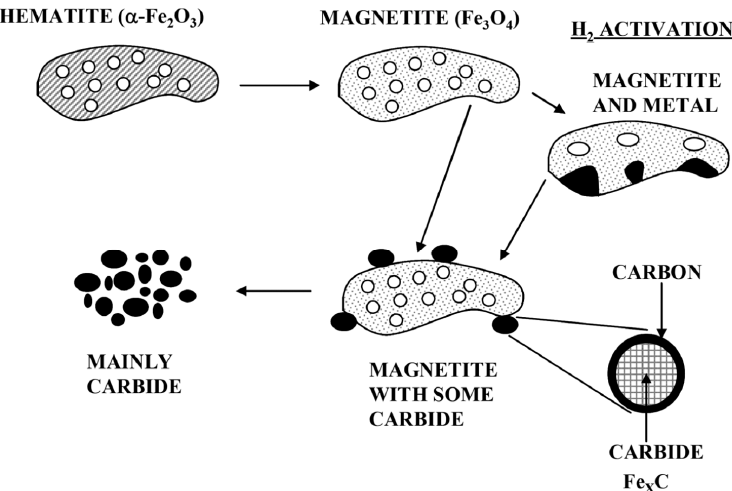
Figure 5. Schematic of morphological and phase changes that occur on the α -Fe 2 O 3 catalyst as a result of activation and reaction conditions [8].